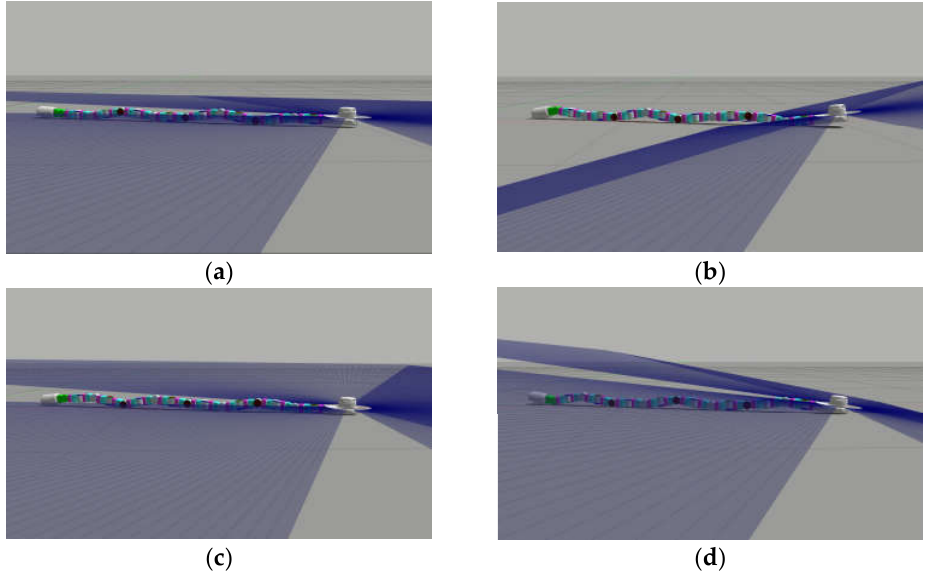
Figure 9. Head stabilization simulation without stabilization algorithm. ( a ) Phase is 0; ( b ) phase is π/2; ( c ) phase is π; ( d ) phase is 3 π/2.